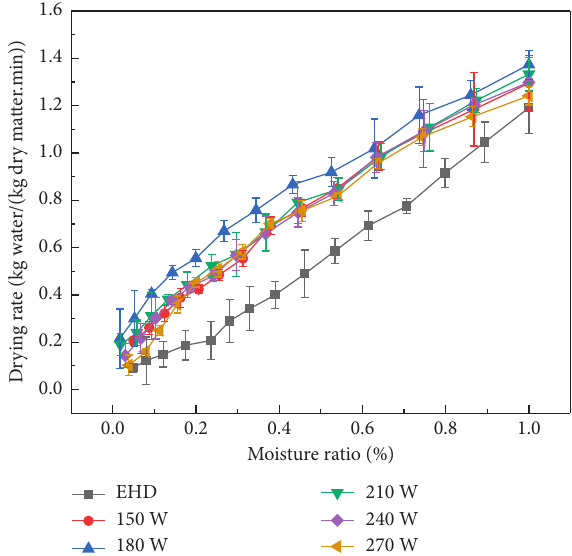
Figure 4: Diagram of the drying rate change in potato slices under different ultrasonic pretreatment conditions.